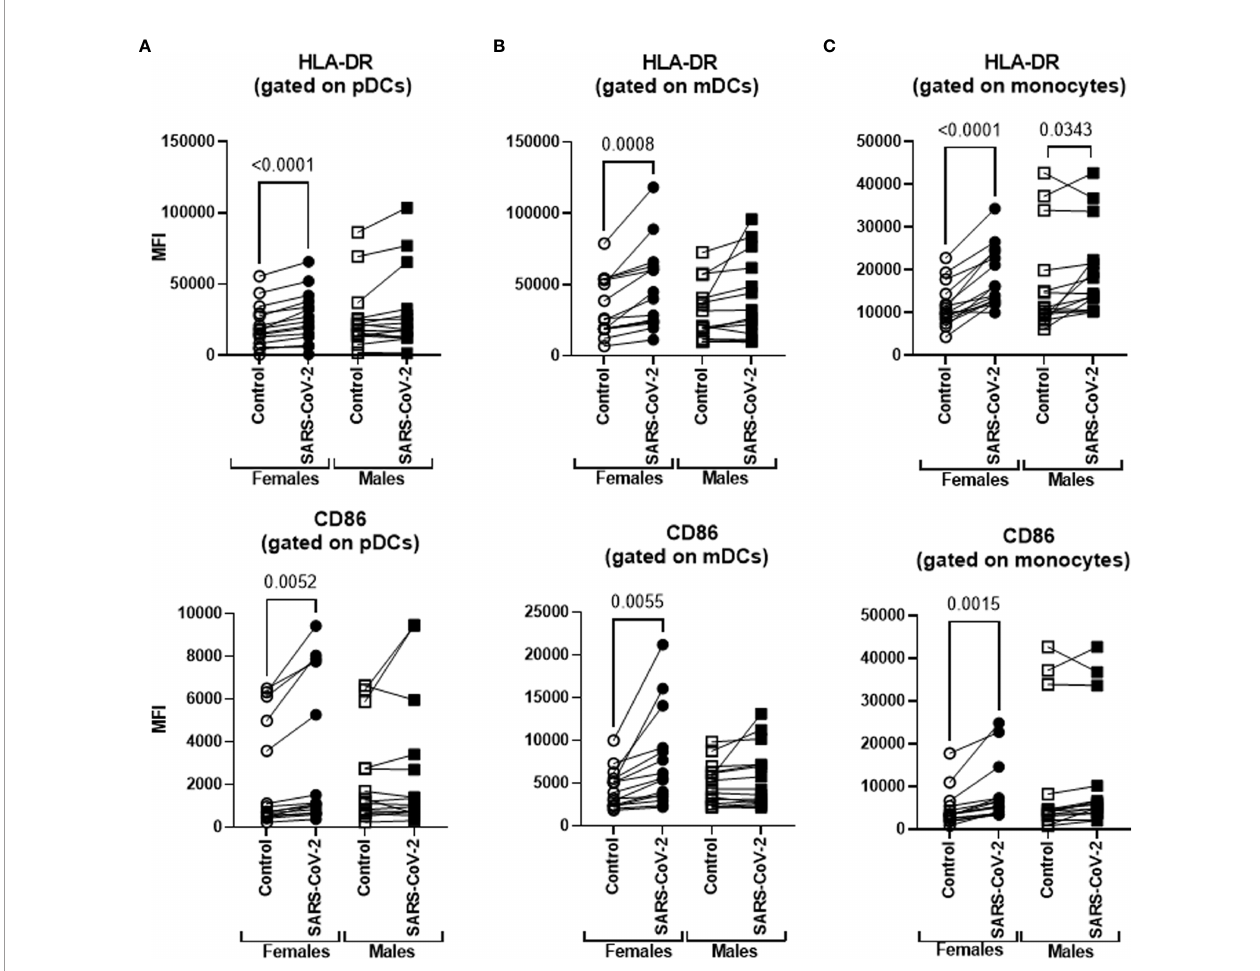
FIGURE 3 | DCs and monocytes from females display enhanced activation in response to SARS-CoV-2 than males. PBMCs were stimulated o/n with irradiated SARS- CoV-2 virus for 24 h. The upregulation of HLA-DR and CD86 was determined using fl ow cytometry. Lines connect the unstimulated and stimulated conditions from the same subject. (A) Gated pDCs (lineage − HLADR + CD123 + ); (B) gated mDCs (lineage − HLADR + CD11c + ); and (C) gated CD14 + monocytes. Mean ± SE. Females = 15; males = 15. p -value between the unstimulated control and SARS-CoV-2-stimulated condition in males and females was calculated using paired t -test